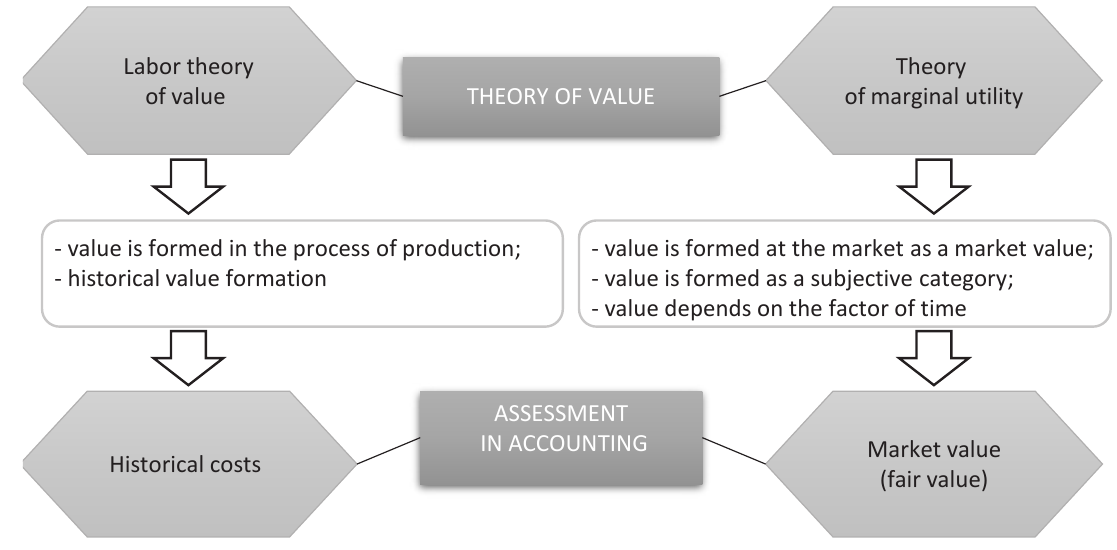
Figure 1. Interrelationships of the theory of value and the theory of marginal utility with assessment in